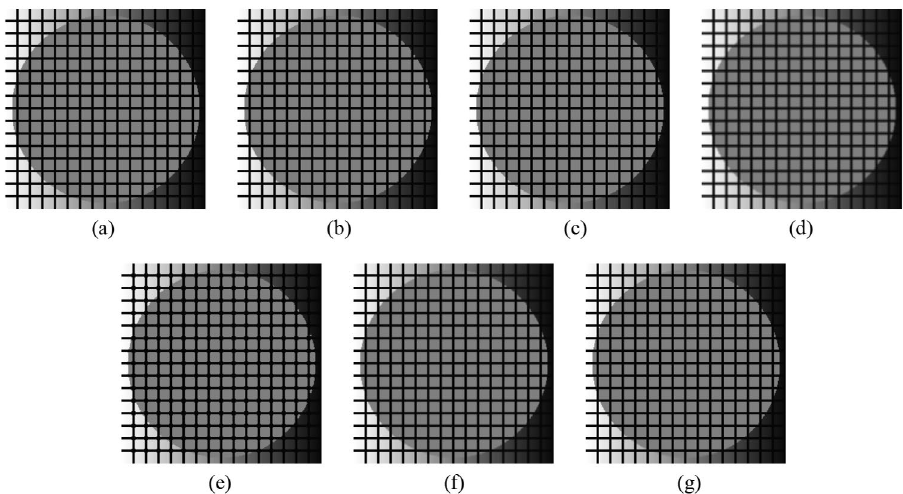
Figure 27. Comparison of edge preservation performance of each filter (“Geometric pattern”). ( a ) Grid- added image; ( b ) filtered image using abwFMGFI; ( c ) filtered image using NLMF (templateWindowSize: 21,